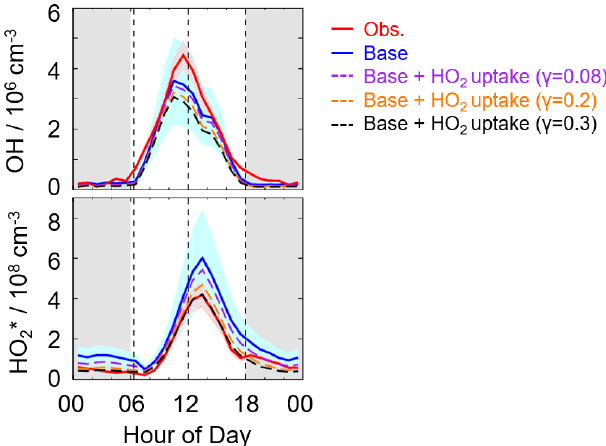
Figure 6. The diurnal profiles of the observed and modeled rad- ical concentrations. The red and blue areas denote 1 σ uncertain- ties of measured and simulated radical concentrations by the base model, respectively. The orange, purple, and black lines denote the simulations by the model which added the HO 2 heterogeneous up- take with a different uptake coefficient. The grey areas denote night- time.